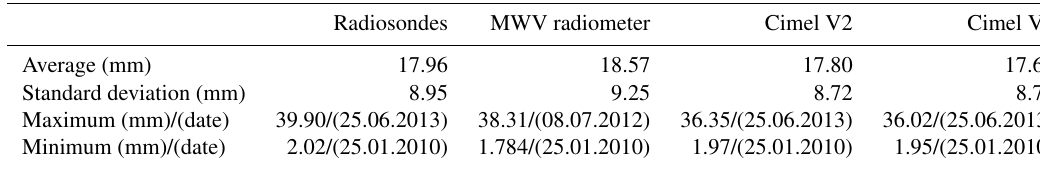
Table 4. Same as Table 2 but just for the common measurements from all instruments. Radiosondes